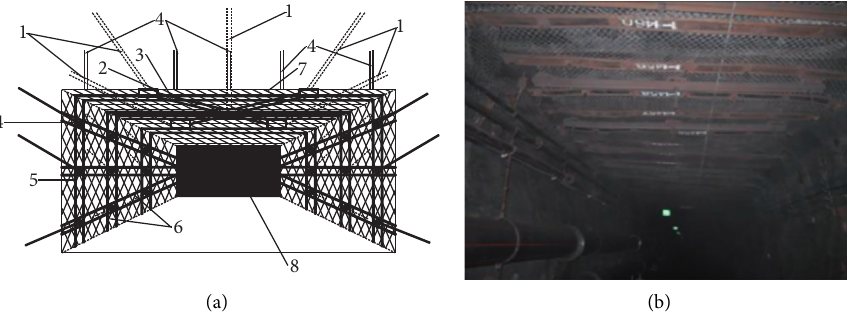
Figure 10: Full space truss and anchor coordinative support system [116]. (a) Schematic diagram.1, cable; 2, pallet; 3, pull rod; 4, anchor; 5, steel wire mesh; 6, steel strip; 7, roof; 8, coal roadway. (b) Site